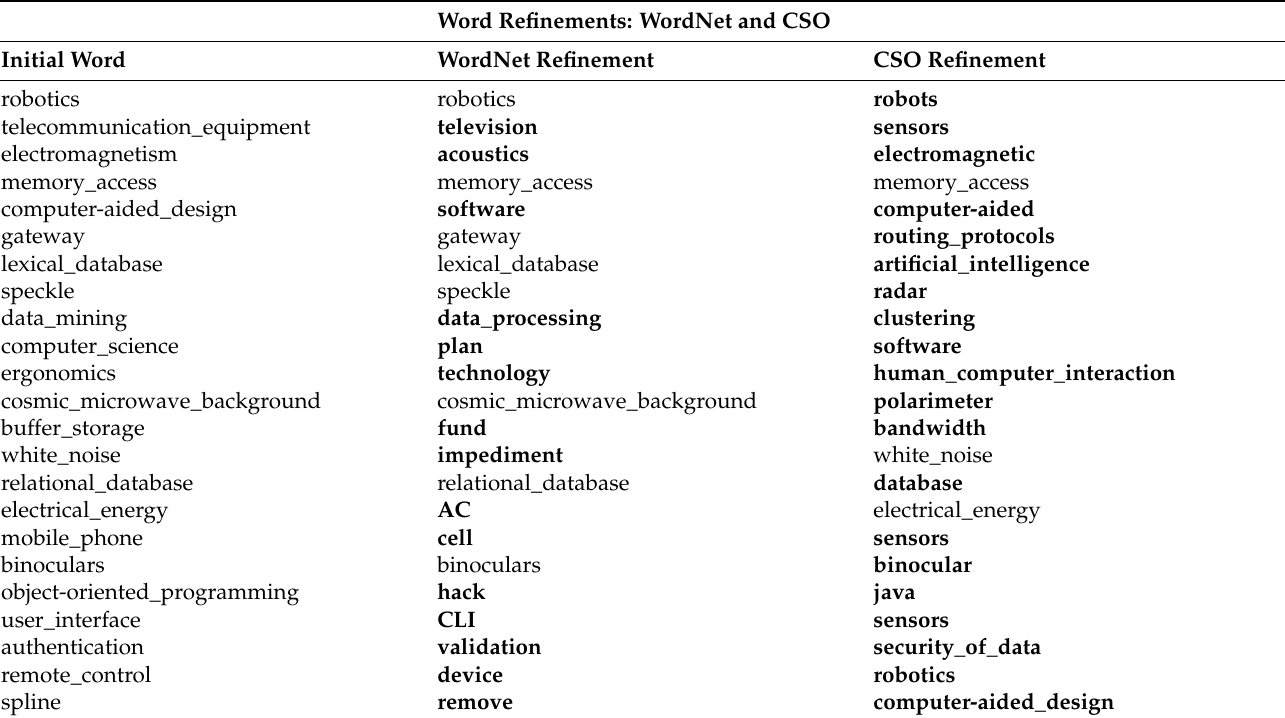
Table 2. List of the different words before and after refining, using WordNet and CSO as ontologies. (An extended version of Table 2 can be found in the Supplementary Materials of this paper.) Word Refinements: WordNet and